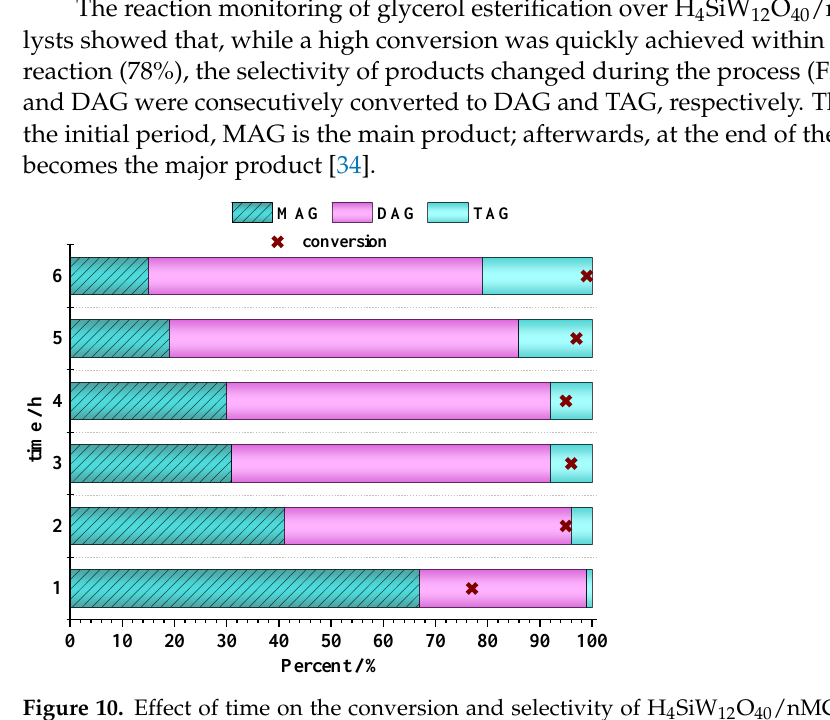
Figure 10. Effect of time on the conversion and selectivity of H 4 SiW 12 O 40 /nMCM − 48-catalyzed esterification of glycerol with acetic acid (adapted from ref. [34]). Reaction conditions: glycerol: HOAc molar ratio (1:6); catalyst load (50 mg); temperature (353